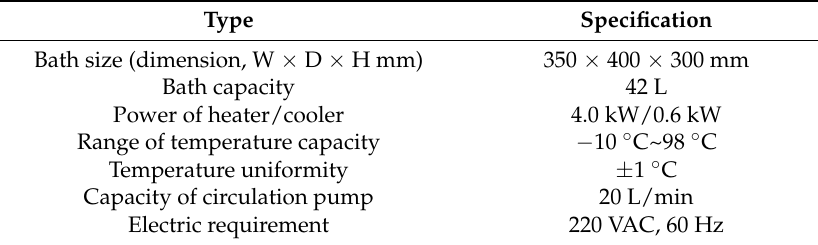
Table 4. Specifications of constant-temperature water bath.